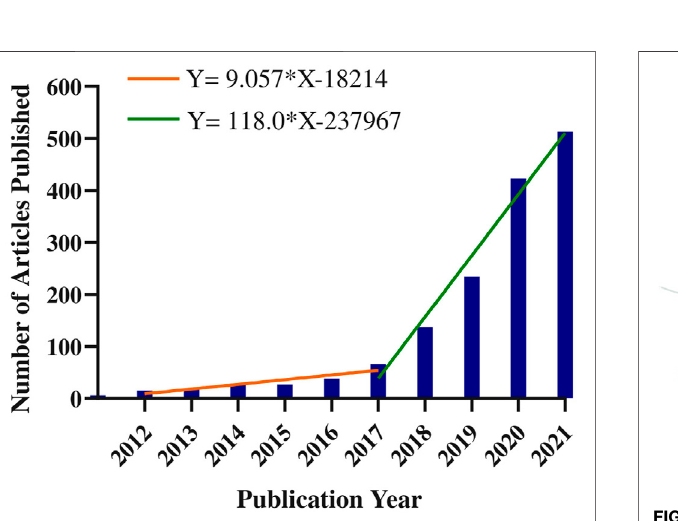
FIGURE2 | Annual number of publications on the applicationof AIin the diagnosis of ophthalmic diseases from 2012 to 2021.